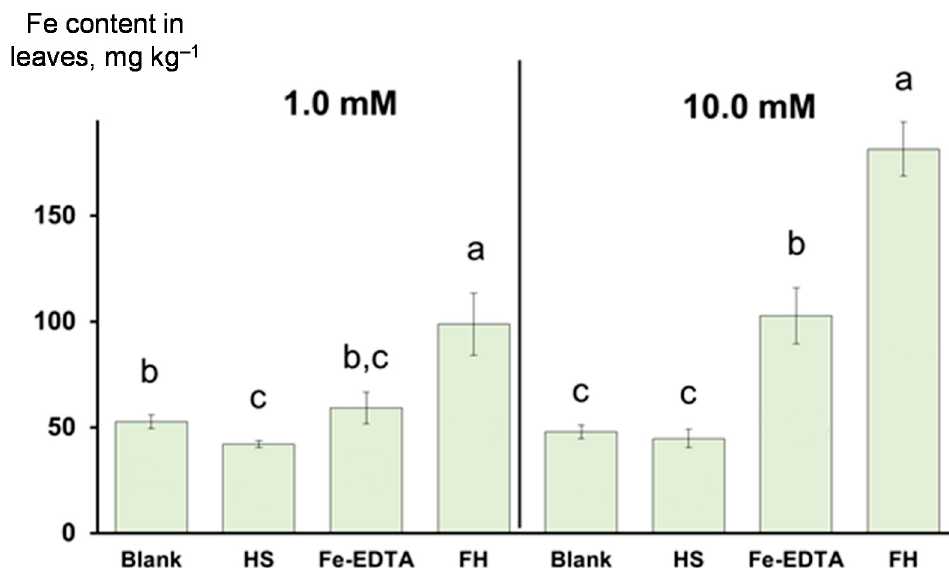
Figure 3. Iron content in the wheat leaves after foliar application of the iron-sources: ferrihydrite (FH) and ferric ammonium salt of ethylenediaminetetraacetic acid (Fe-EDTA), and control solutions: triple-distilled water (blank) and potassium humate (HS). The iron concentrations in the fertilizer sprays were 1.0 mM (left panel) and 10.0 mM (right panel). All treatments, except for the blank, contained urea adjuvant (0.2% wt.). The bars represent the standard deviation ( n = 4). The columns marked with di ff erent letters are significantly di ff erent at p < 0.05 according to the least significant di ff erence (LSD) test.